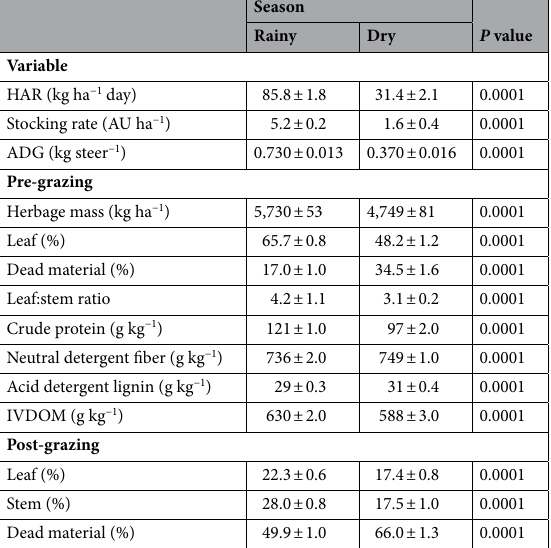
Table 4. Average, standard error of mean (±)for herbage accumulation rate (HAR), stocking rate, average daily gain (ADG), pre-grazing herbage mass, leaf and dead material percentages, leaf:stem ratio, crude protein, neutral detergent fiber and acid detergent lignin concentrations, in vitro digestible organic matter (IVDOM) of leaves, and post grazing leaf, stem and dead material percentages in P. maximum cv. Mombaça guinea grass pastures subjected to rotational stocking and fertilized with three nitrogen levels, during the rainy and dry